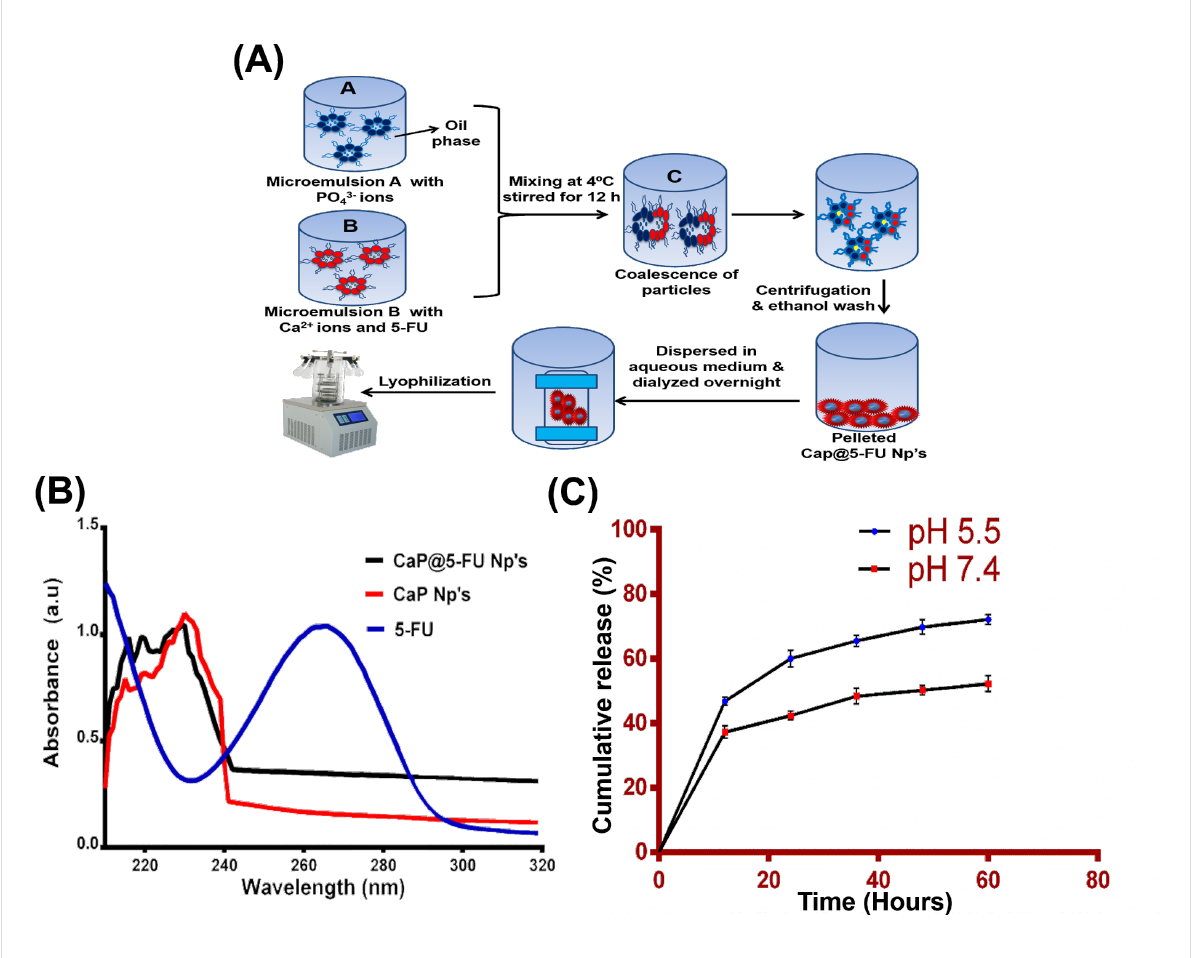
Figure 1: (A) Schematic representation for the preparation of CaP@5-FU NPs. (B) The UV–visible spectrum of CaP@5-FU NPs (black line), CaP NPs (red line) and 5-FU (blue line). (C) The pH-triggered release profile of 5-FU from the CaP@5-FU NPs with respect to